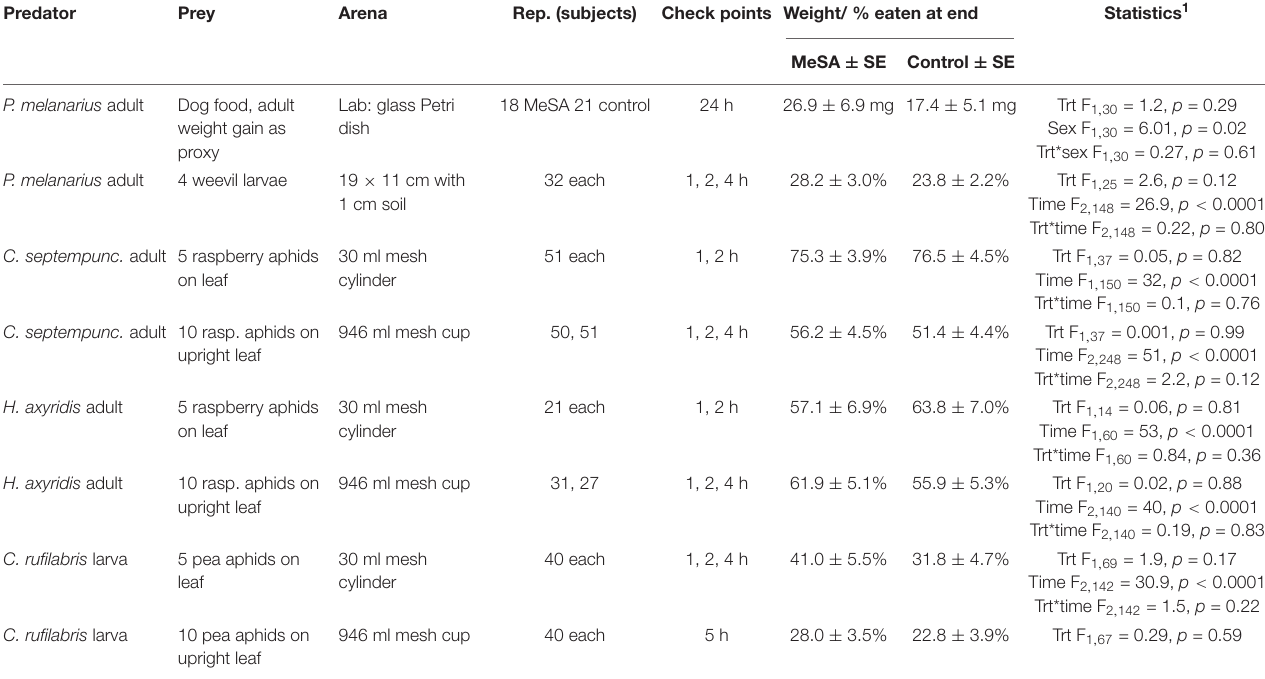
TABLE 1 | Experimental design, mean predation, and statistical outcomes of predation trials in the presence/absence of MeSA volatiles. Predator Prey Arena Rep. (subjects) Check points Weight/ % eaten at